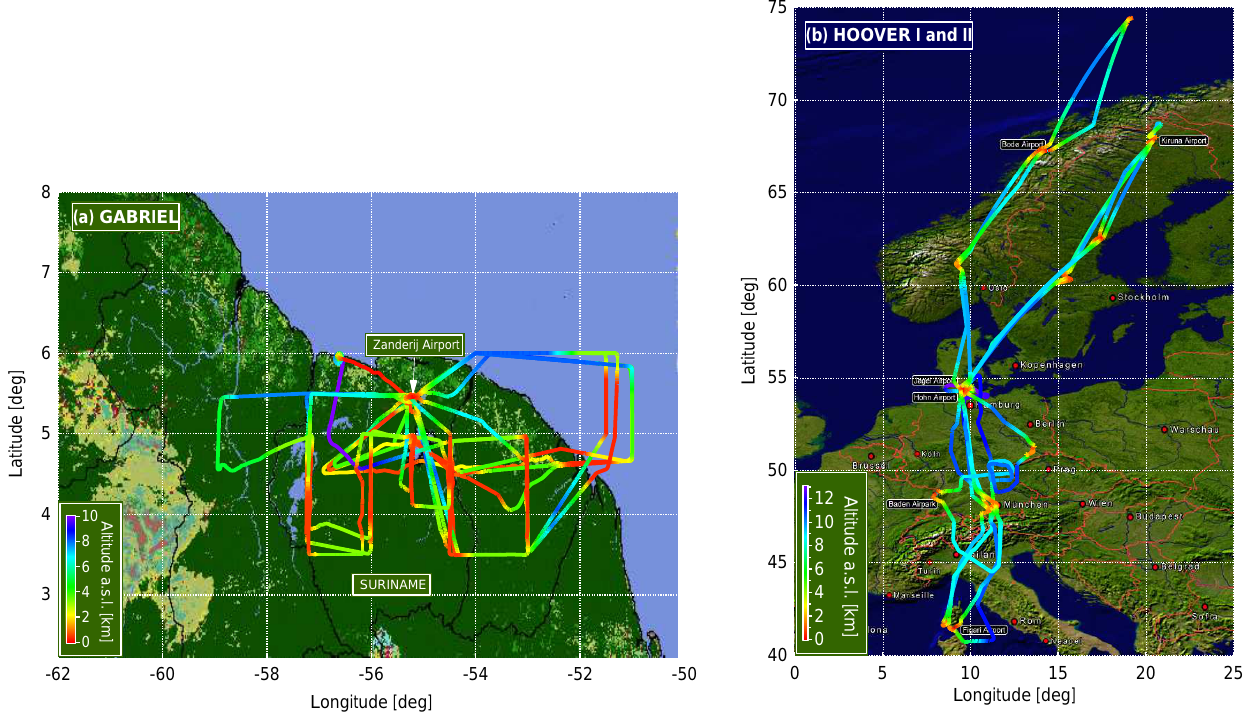
Figure 1. Flight tracks during GABRIEL (a) and HOOVER I and II (b)